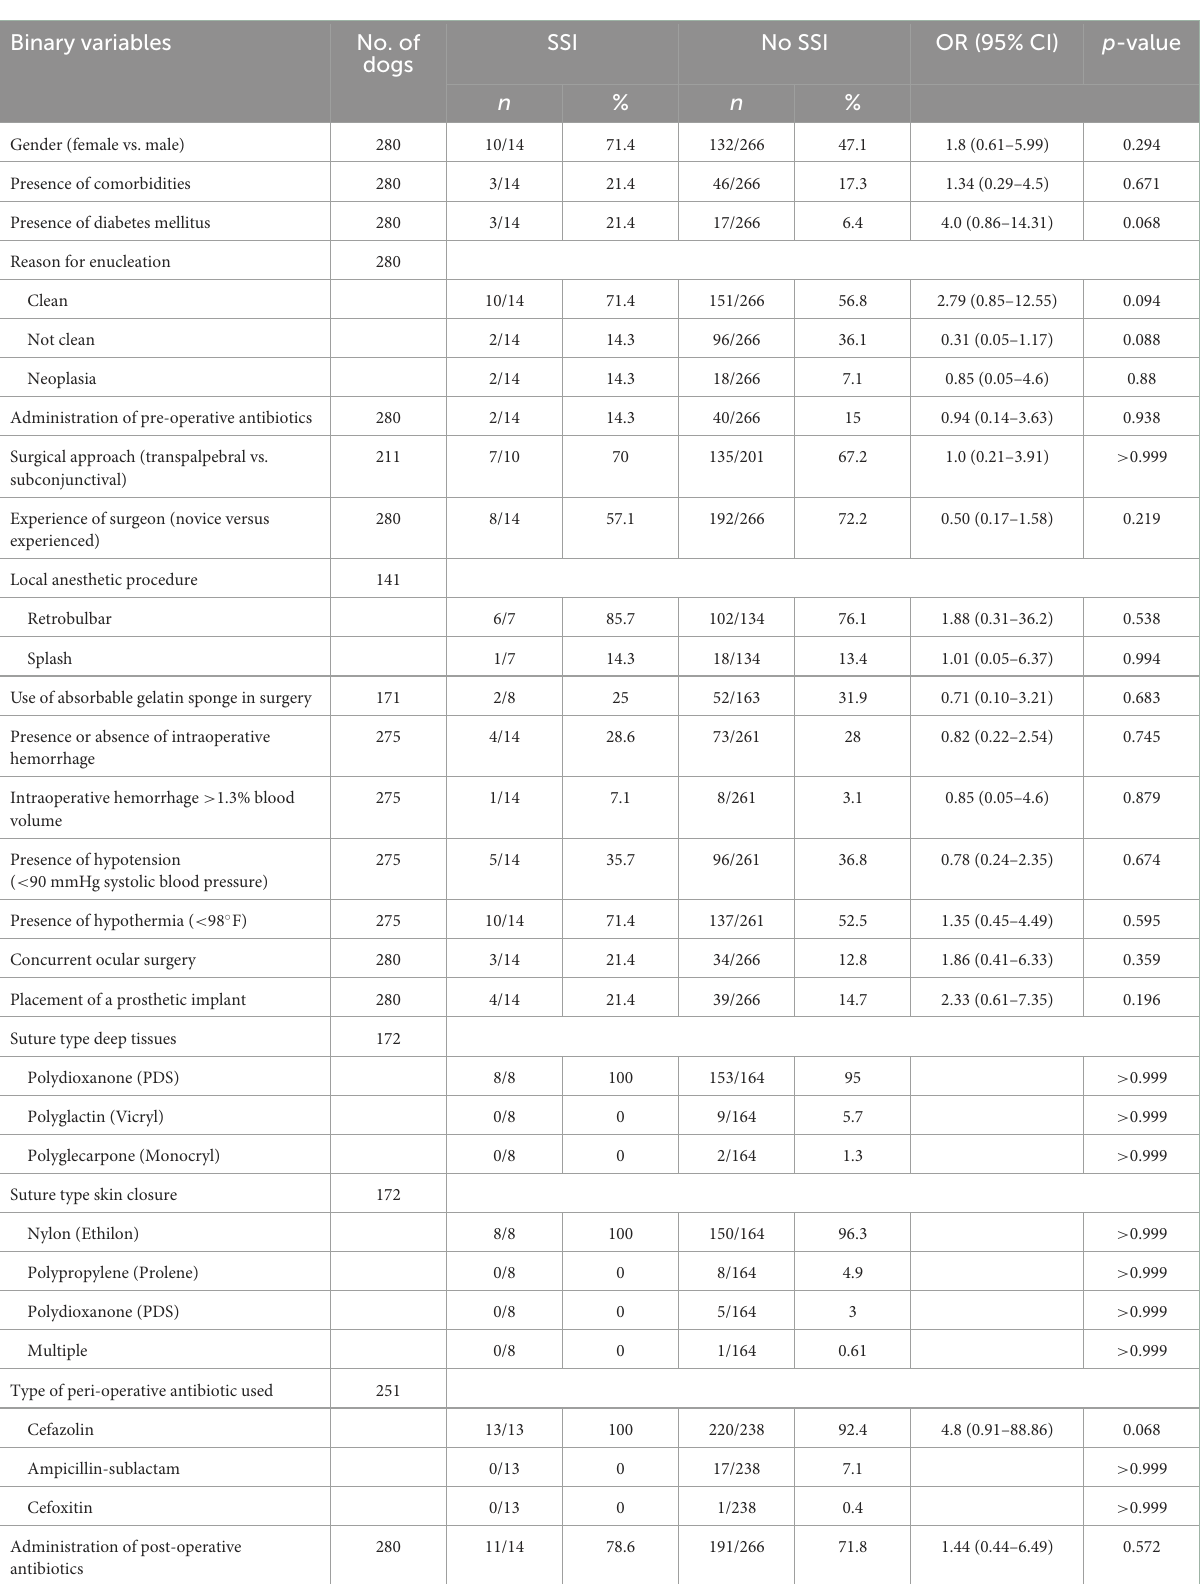
TABLE 2 Characteristics of the study cohort and results of univariable logistic regression and Fisher’s exact test to assess for risk factors associated with surgical site infection after enucleation in dogs. Binary